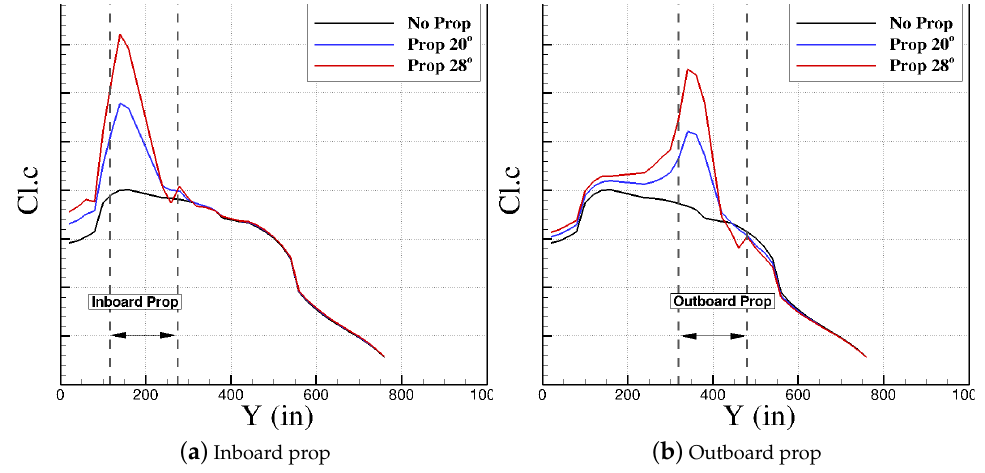
Figure 11. Local lift distribution for wing and propellers installed inboard or outboard the wing. Propellers have 20-deg or 28-deg blade angles. The propellers spin counter clockwise. In these figures, C l . c denotes the local lift times the local chord length. Local lift data are found from time-averaged solutions.